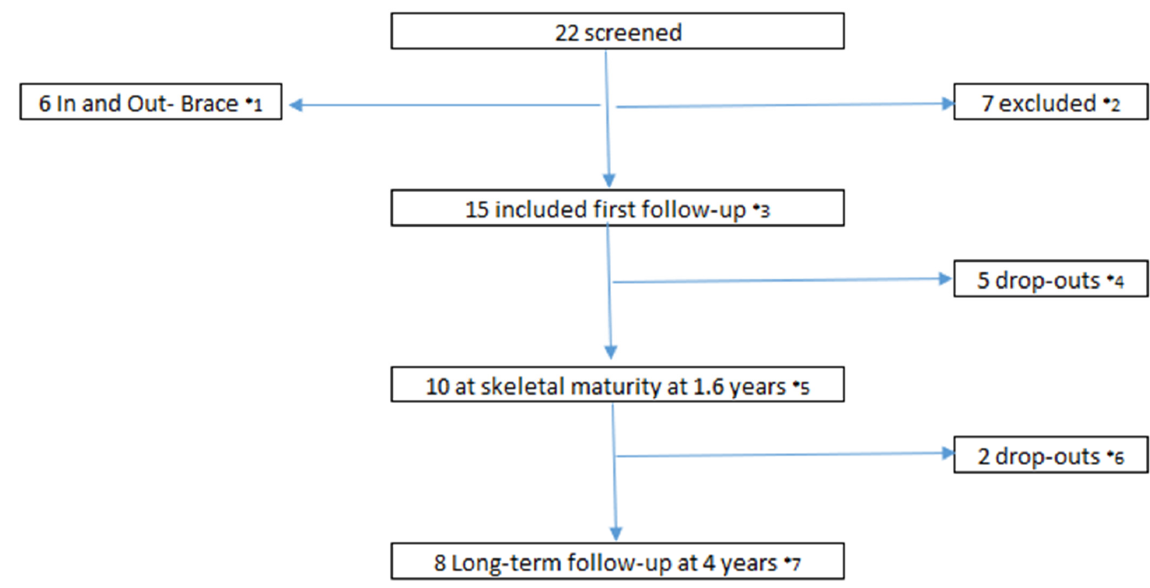
Figure 3. Timeline of the subject’s participation. * 1 Six patients had initial in and out-of-brace radiographs as part of the inclusion process. * 2 Seven patients did not fulfil the inclusion and exclusion criteria, thus were excluded. * 3 Fifteen subjects were included with an improvement of one-fourth in Cobb’s angle. * 4 Five subjects dropped out due to change to other brace strategies by their own accord. * 5 Evaluation at skeletal maturity and when the soft brace was discontinued. * 6 Two subjects did not participate in the follow-up at four years. * 7 Evaluation at follow-up at four years. For the ten subjects at skeletal maturity in the follow-up study, the average age at brace initiation was 12.26 (SD: 2.76) years. The clinical characteristics of the subjects and relevant medical history are summarized in Table